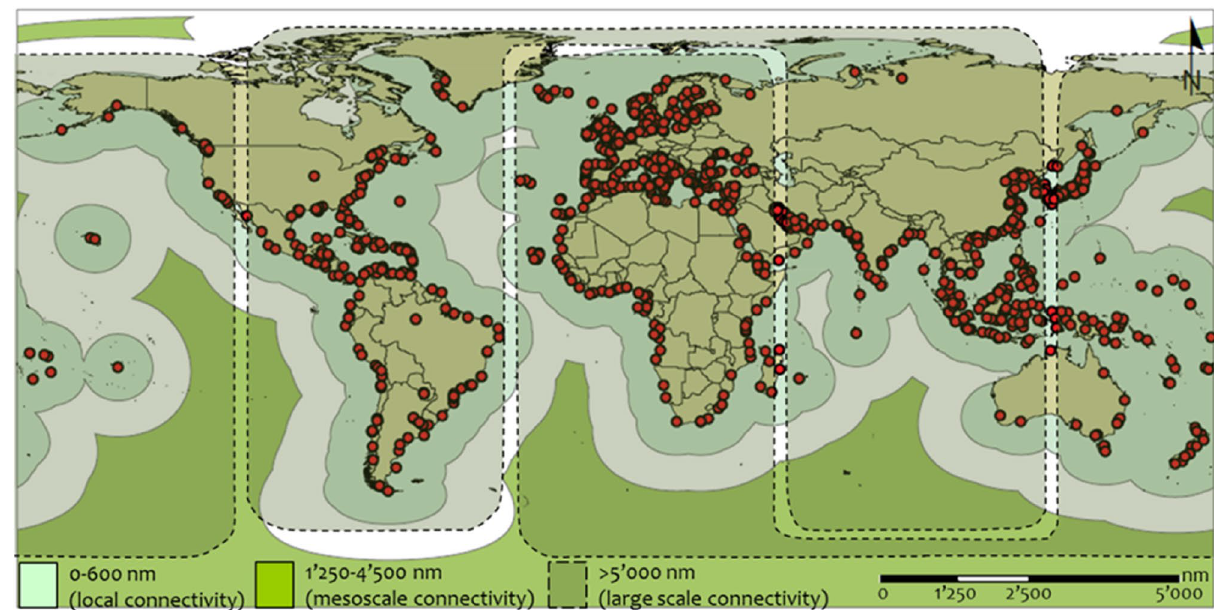
Figure 7. Zone buffering of the geographical scales (local, mesoscale, and large connectivity) of the GCSN functionality, as revealed from the analysis (own elaboration based on ESRI ArcGIS 10.50; https:// www. arcgis.